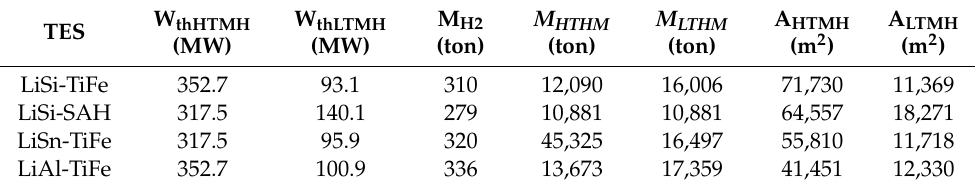
Table 1. Mass and energy balances for the selected TES systems.